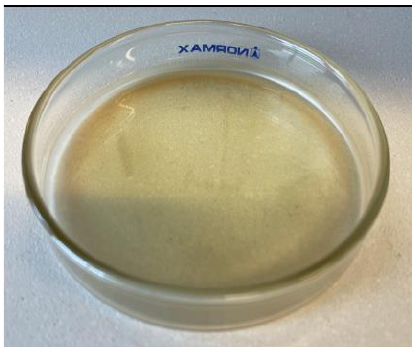
Figure 1. A typical membrane cast in a flat Petri